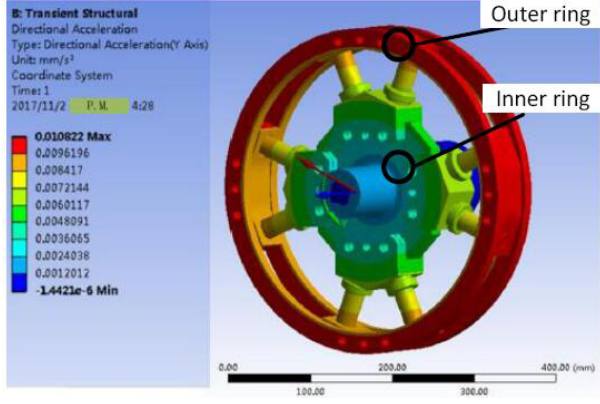
Figure 8. Simulation results of the vibration